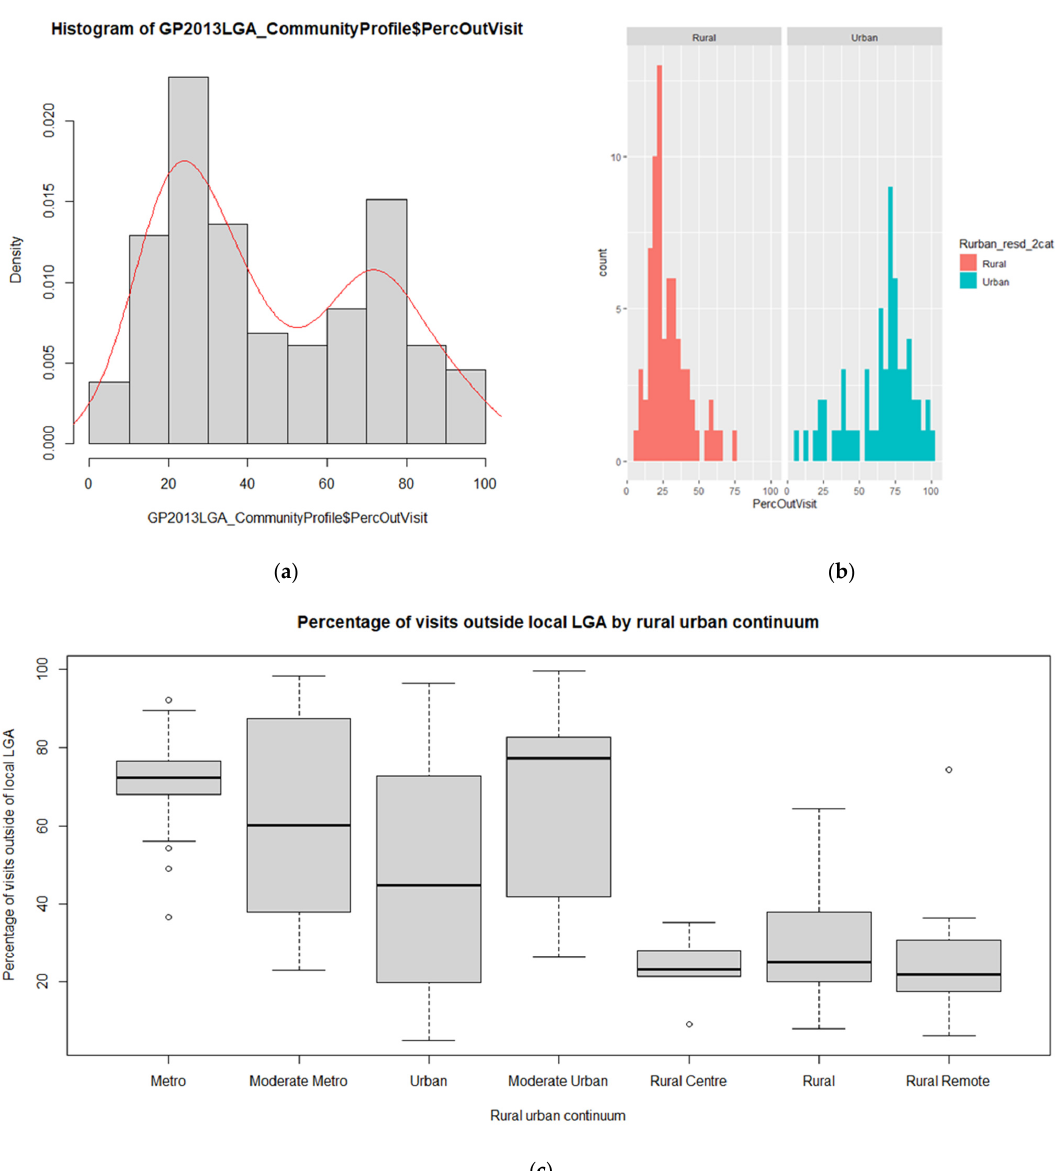
Figure A1. Histograms of non-local PCP utilization at provincial level ( a ), broad rural and urban area level ( b ), and boxplots of non-local PCP utilization at rural–urban continuum level ( c ).